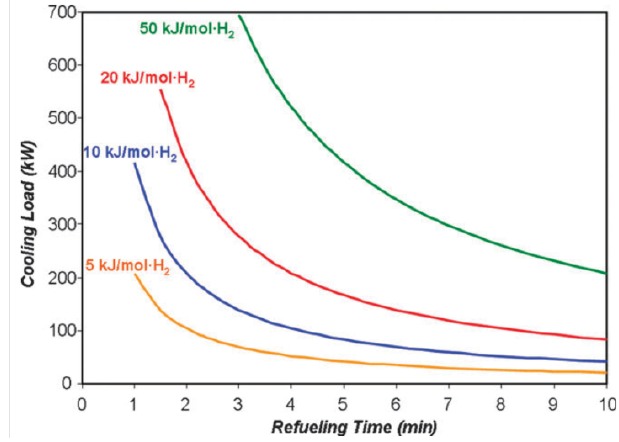
Figure 4. Theoretically required cooling load (kW) as a function of refueling time (min) for absorbing 5 kg of H 2 into storage materials of various ∆ H. Reproduced with permission [76]. Copyright 2010, Royal Society of